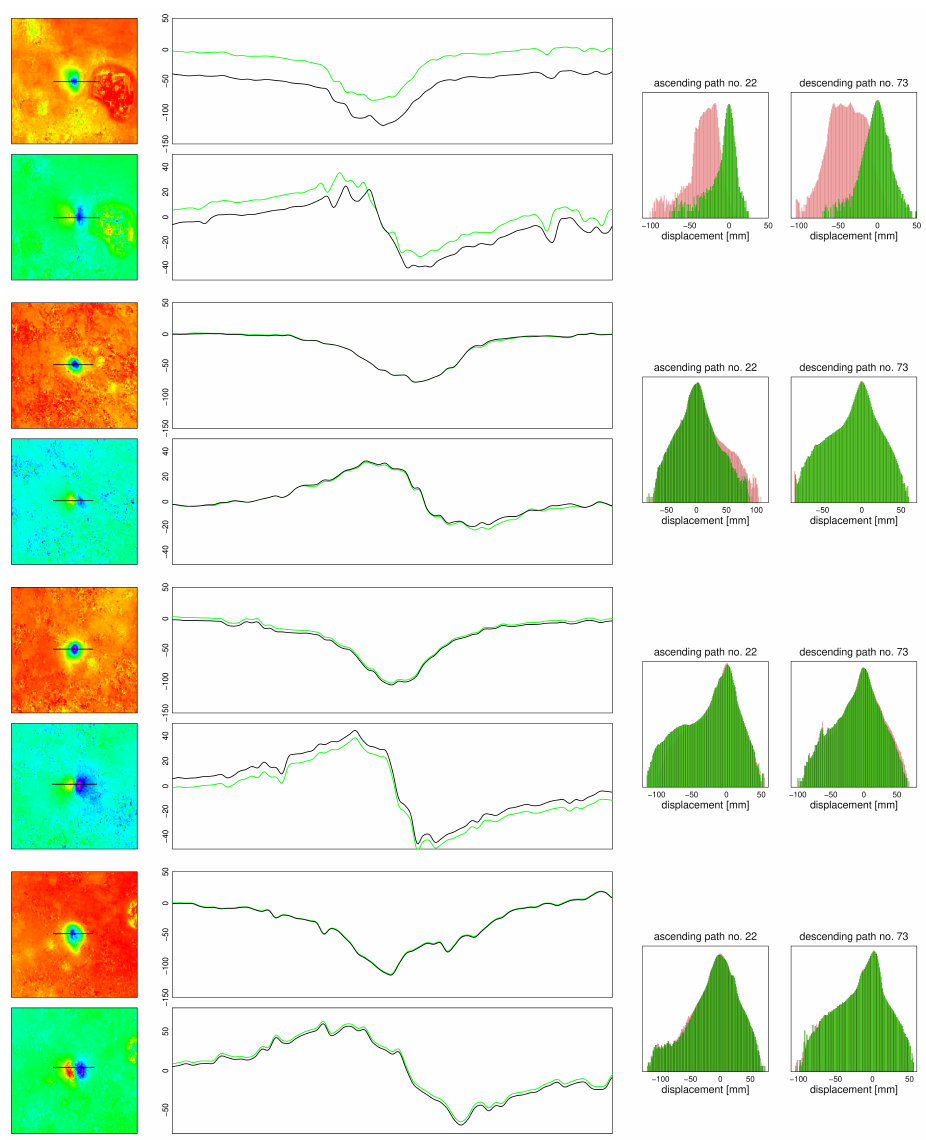
Figure 10. Comparison of the displacement values obtained before (black line) and after (green line) applying the tropospheric correction for the LGCB area. Maps show vertical displacements before and after correction, as well as E-W displacements before and after correction. Histograms show LOS displacements for paths (ascending and descending) before and after tropospheric